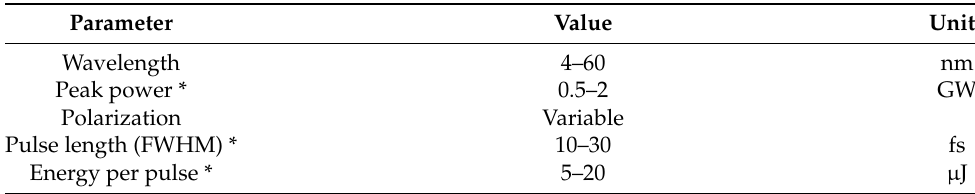
Table 6. Expected parameters of the external seeded FEL (* these values might be wavelength